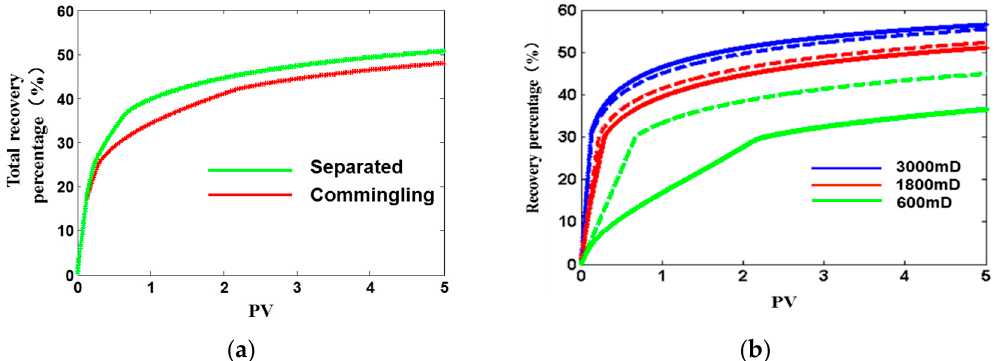
Figure 6. Comparison of recovery percentage in the reservoir ranging from 0 to 5 PV ( a ) separated and commingling production; ( b ) each different permeability layer (solid line, commingling production; dotted line, separated production).